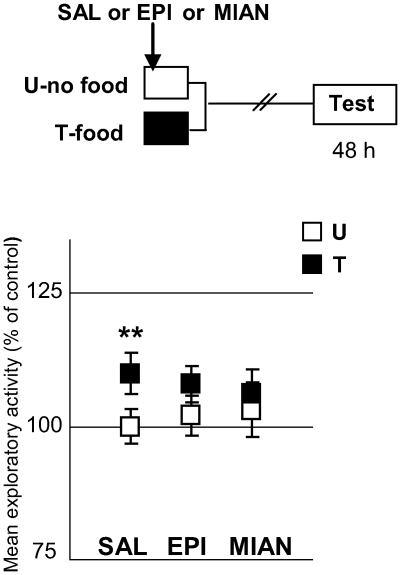
OA antagonists impair appetitive memory.(Upper diagram): Experimental protocol. Symbols as in Fig. 6A. Three U–T pairs: SAL (N = 36), 6 mM EPI (N = 35) and 5 mM MIAN (N = 38) applied 5 min after being in the container, at the onset of the appetitive training trial (arrow). (Lower panels): Results of the Testing session. Ordinates and symbols as in Fig. 6A.